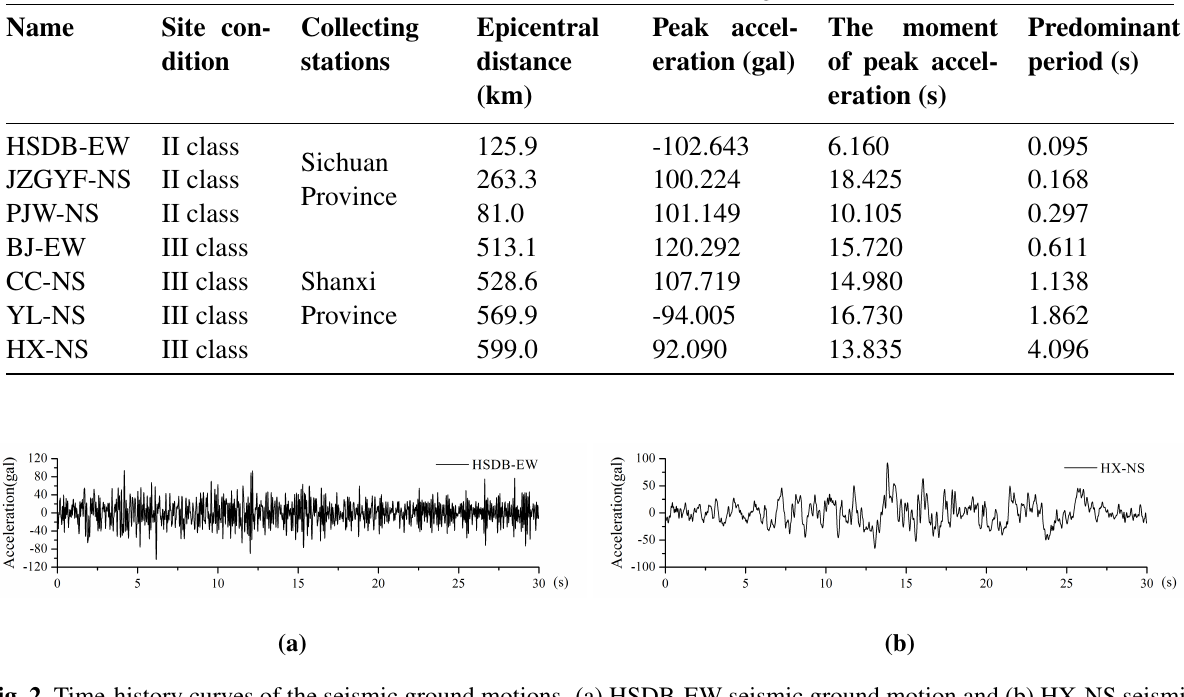
Fig. 2 Time-history curves of the seismic ground motions. (a) HSDB-EW seismic ground motion and (b) HX-NS seismic ground